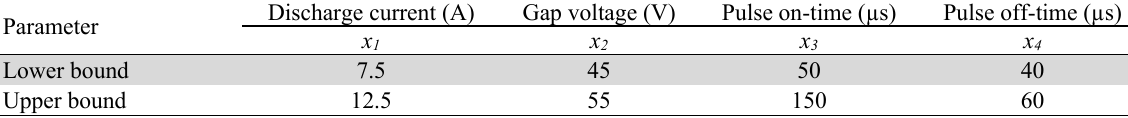
The mathematical predictive regression models for performance parameters MRR , Ra and REWR obtained by Tzeng and Chen (2013) are given in the Eq. (5) - (7) respectively. 𝑀𝑅𝑅 = − 253.15 + 39.7 𝑥